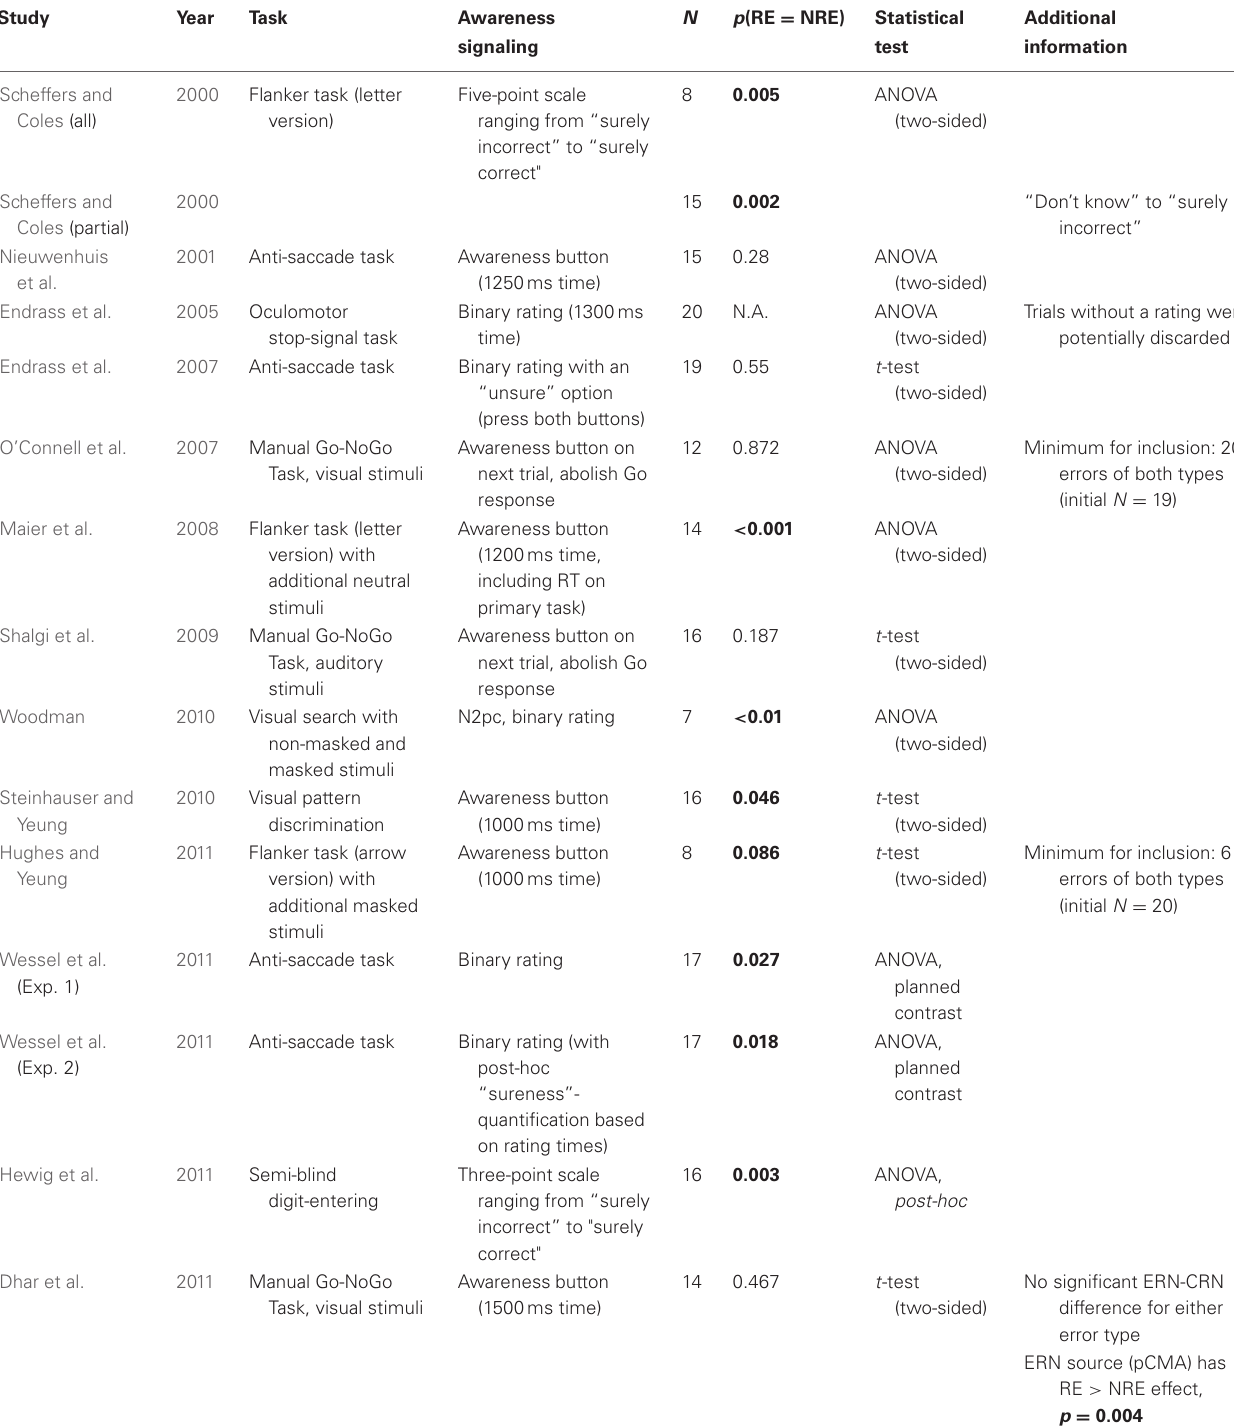
Table 1 | Details of the studies that report testing of ERN amplitude differences for reported vs. non-reported errors, either as part of their main hypothesis or as auxiliary